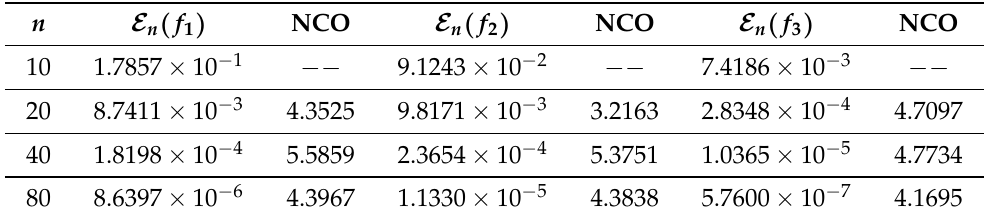
Table 1. Estimated errors for functions f 1 , f 2 and f 3 , and NCOs with different values of n .